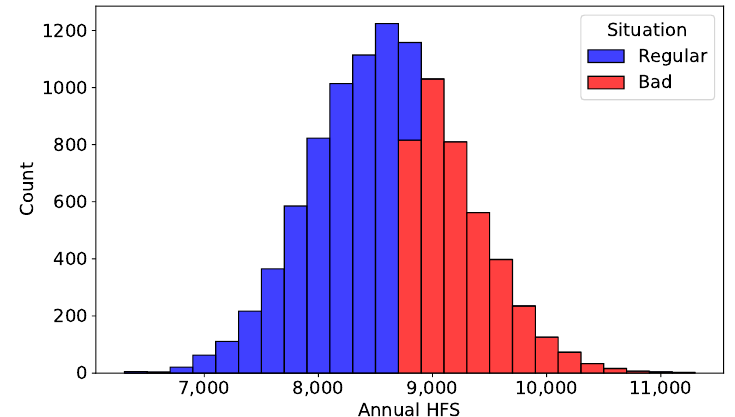
Figure 10. Histogram Highlighting Possible Operating Situations—Simulation